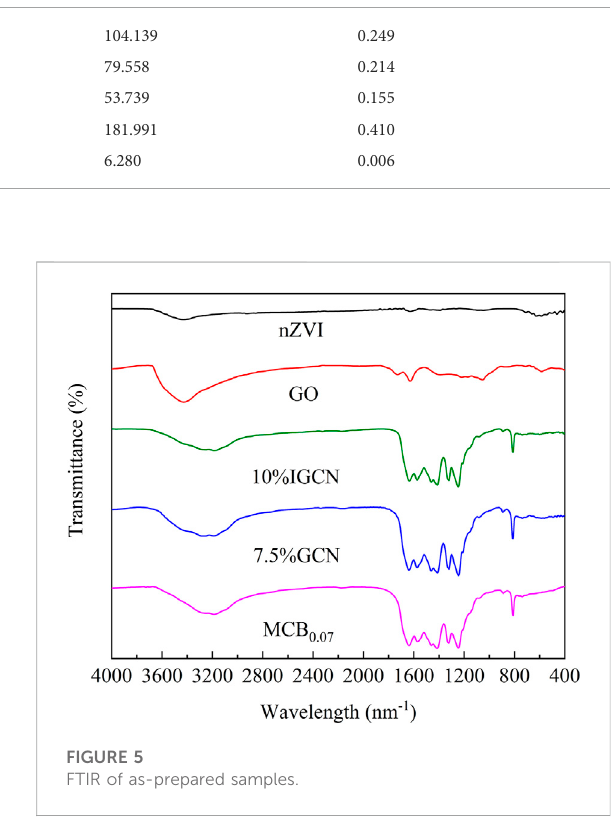
FIGURE 4 XRD of as-prepared samples.